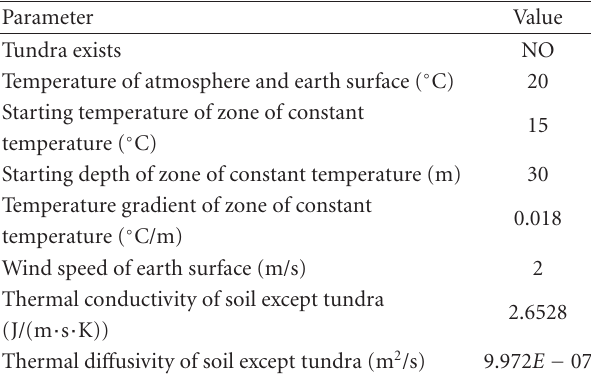
Table 10: Parameter of